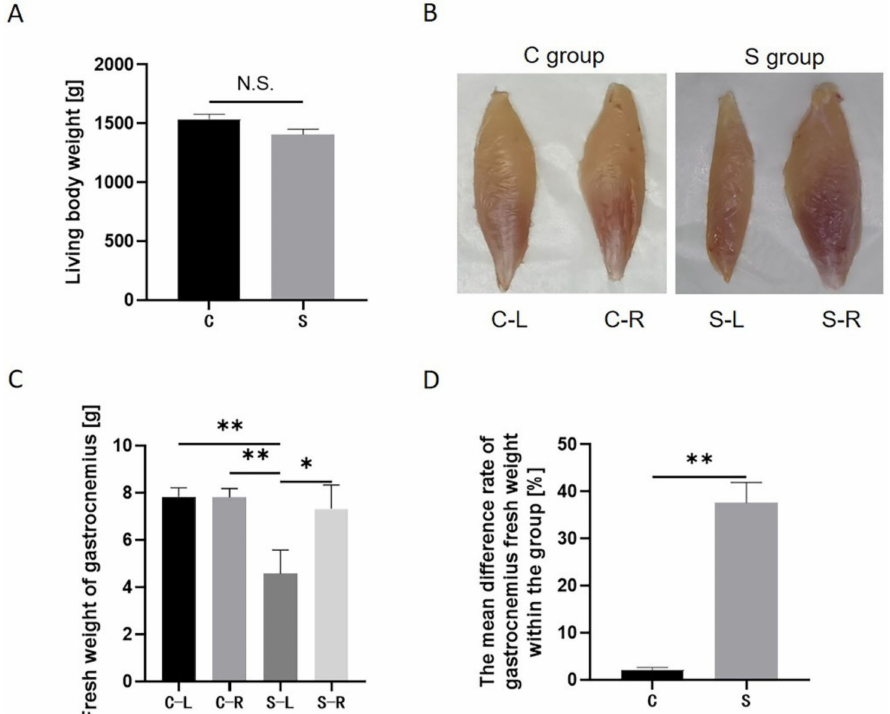
Figure 1. Atrophy model leads to loss of muscle mass. ( A ) Live body weight of each group before sampling. ( B ) Schematic diagram of the gastrocnemius muscle of each group after sampling. ( C ) Fresh weight of gastrocnemius muscle of each group. ( D ) Mean difference rate of gastrocnemius fresh weight within the group. Data are presented as mean ± SEM ( n = 6 biologically independent samples). * p < 0.05; ** p < 0.01 (Student’s t